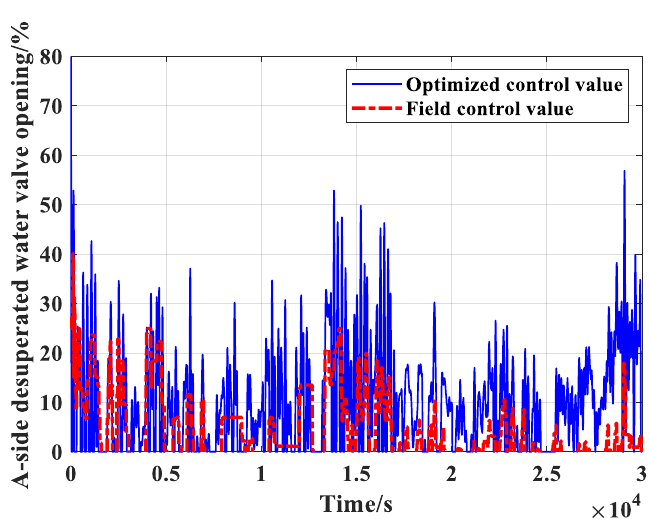
Figure 15. Output of controller A.